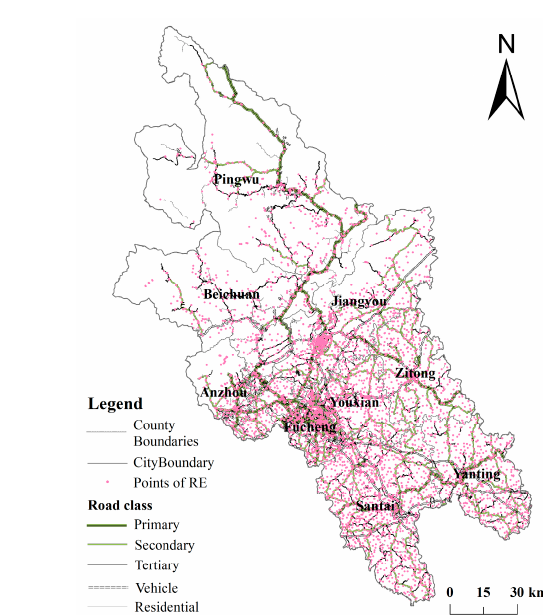
Figure 3. Distribution of rural entrepreneurship based on the Digital Elevation Model of Mianyang ( left panel) and the road network of Mianyang ( right panel).